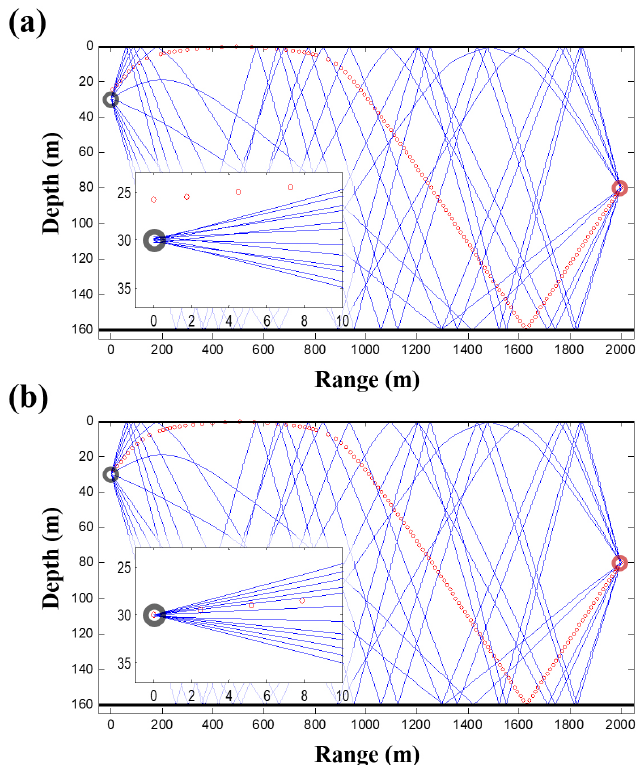
Figure 8. Backpropagated ray trajectories of arrivals less than 30 ◦ . The reference and estimated sound speed profiles are used for ( a ) and ( b ), respectively. The inset shows an enlarged diagram revealing incorrect/correct convergence to the source